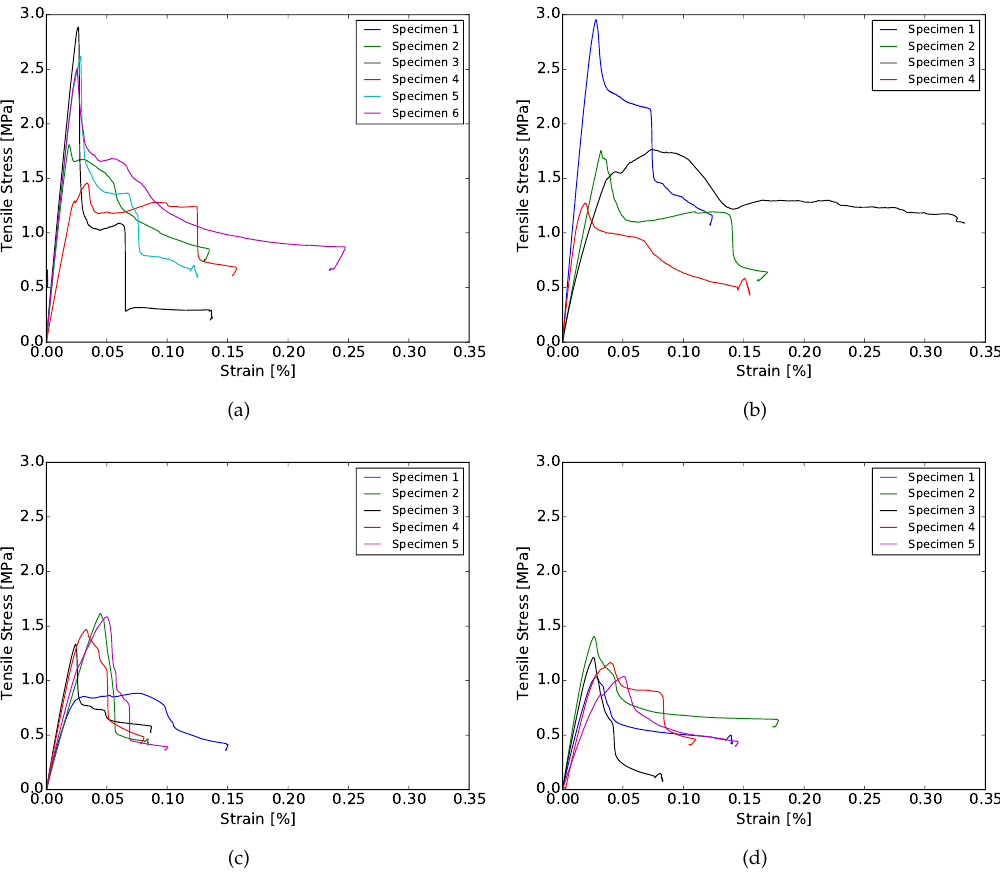
Figure 13. Layer interface tensile bond strength. ( a ) X2T; ( b ) X2TT; ( c ) Y2T; ( d )